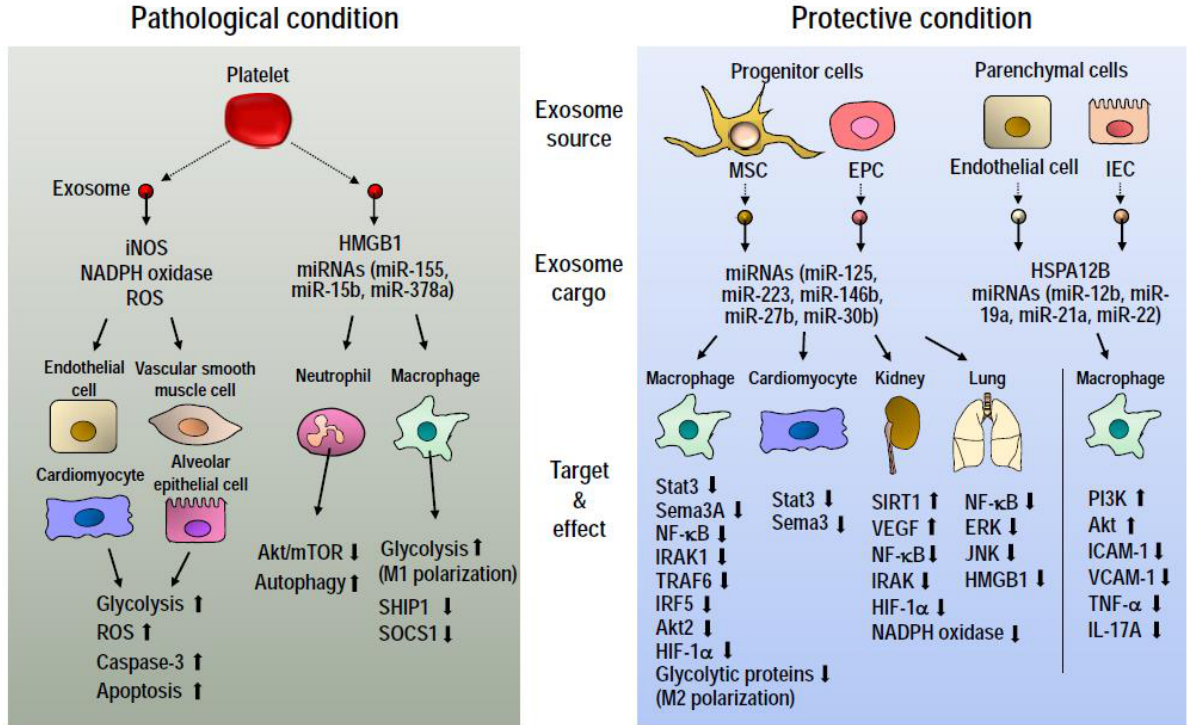
Figure 3. Potential roles of exosomes in the regulation of cellular metabolism in sepsis. Exosomes mediate both pathological and protective events in sepsis. Depending on their cargo/payloads and pathways modulated in target cells, metabolic roles of exosomes in sepsis pathophysiology may differ. During sepsis platelets release exosomes carrying bioactive molecules that promote inflammatory events and pathways associated with glycolysis in both parenchymal and immune cells. Exosomes originating from mesenchymal stem cells and endothelial progenitor cells (and in some cases, parenchymal cells) downregulate inflammatory pathways and preserve function of several tissues in sepsis; a disease phenotype akin to restoration of metabolic homeostasis. Upward and downward wide-tail arrows indicate increase and decrease, respectively.